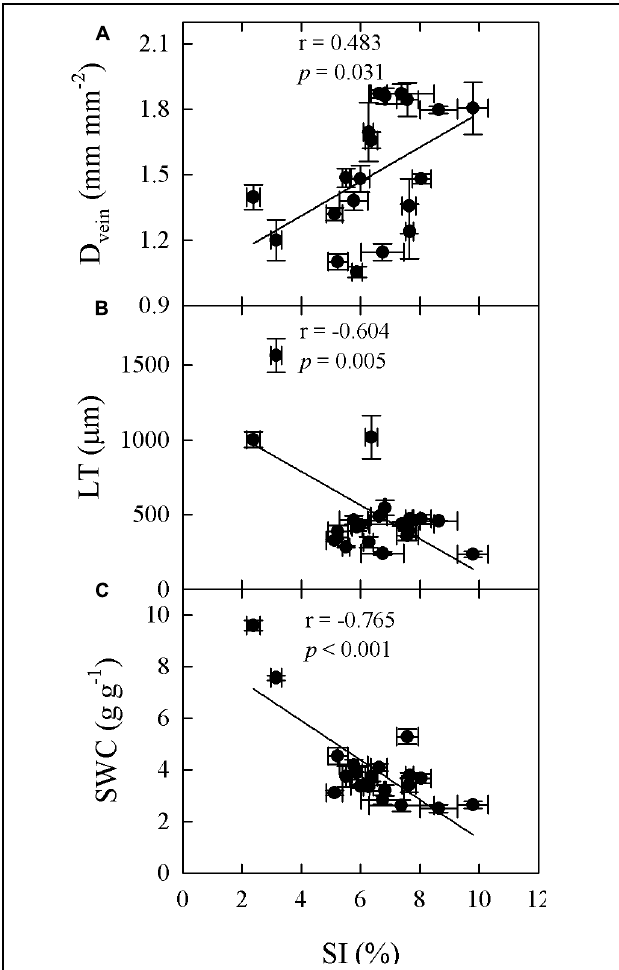
FIGURE 7 | Correlations between SI and leaf vein density (D vein ; A), LT (B), and SWC (C) across 20 Cymbidium